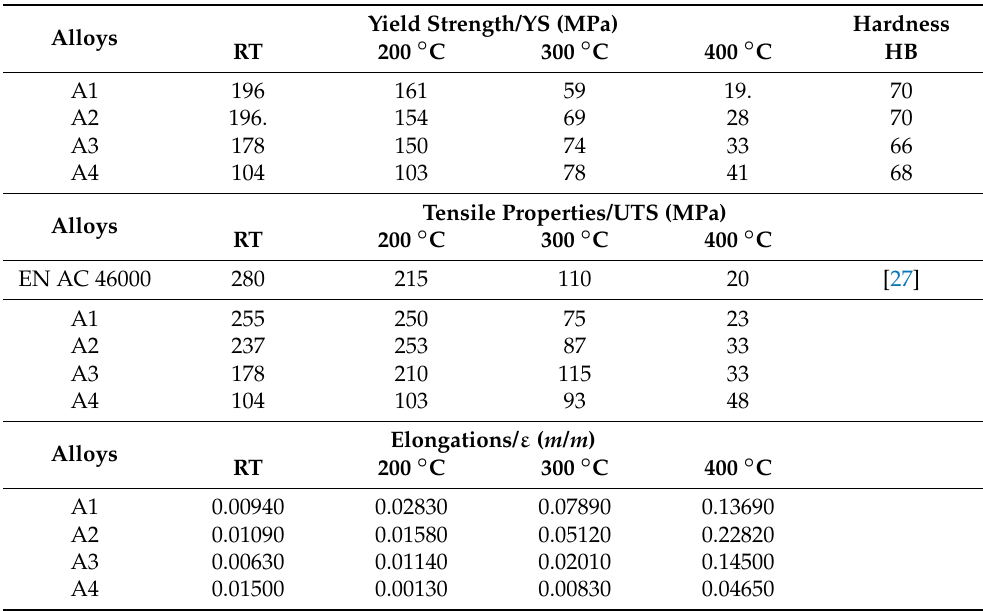
Table 4. Room and high-temperature tensile test results with a comparison to EN